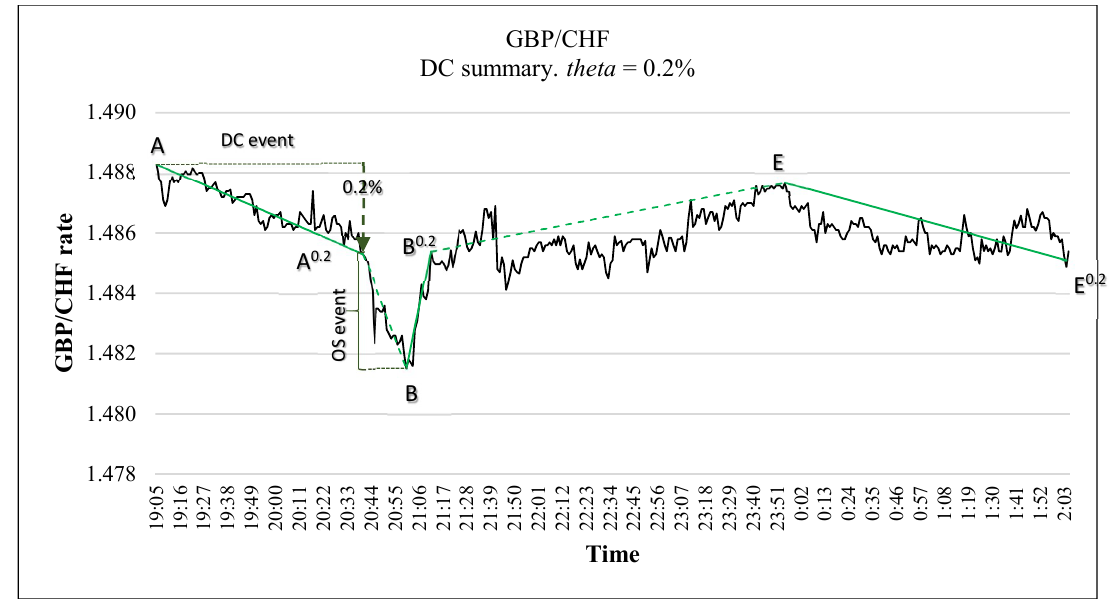
Figure 3. An example of a DC-based summary of the price series shown in Figure 1. Threshold theta = 0.2%. The black line indicates GBP/CHF mid-prices. Solid green lines represent DC events. Dashed green lines represent OS events. Each of the points A, B, E is an extreme point. Each of the points A 0.2 , B 0.2 , E 0.2 is a DC confirmation point.